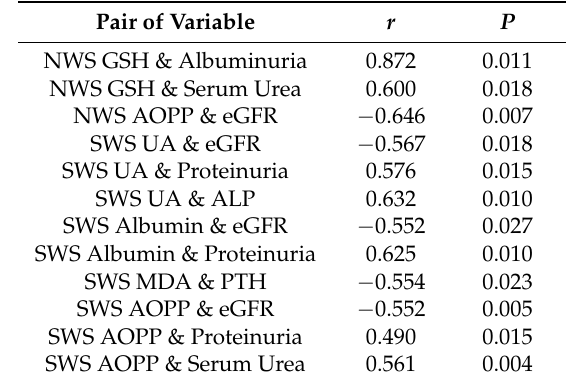
Table 5. Correlations between oxidative stress biomarkers and clinical parameters in children with chronic kidney disease